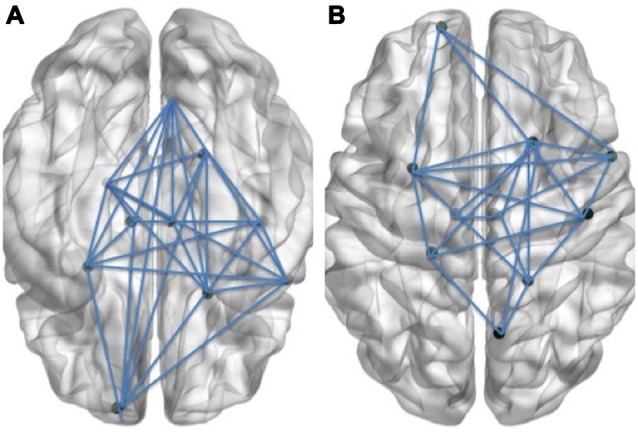
Schematic visual illustration of the Language (A) and Cognitive control (B) networks. In these schematic figures, the right hemisphere of the brain is shown on the right side of each figure and the left hemisphere is shown on the left side.